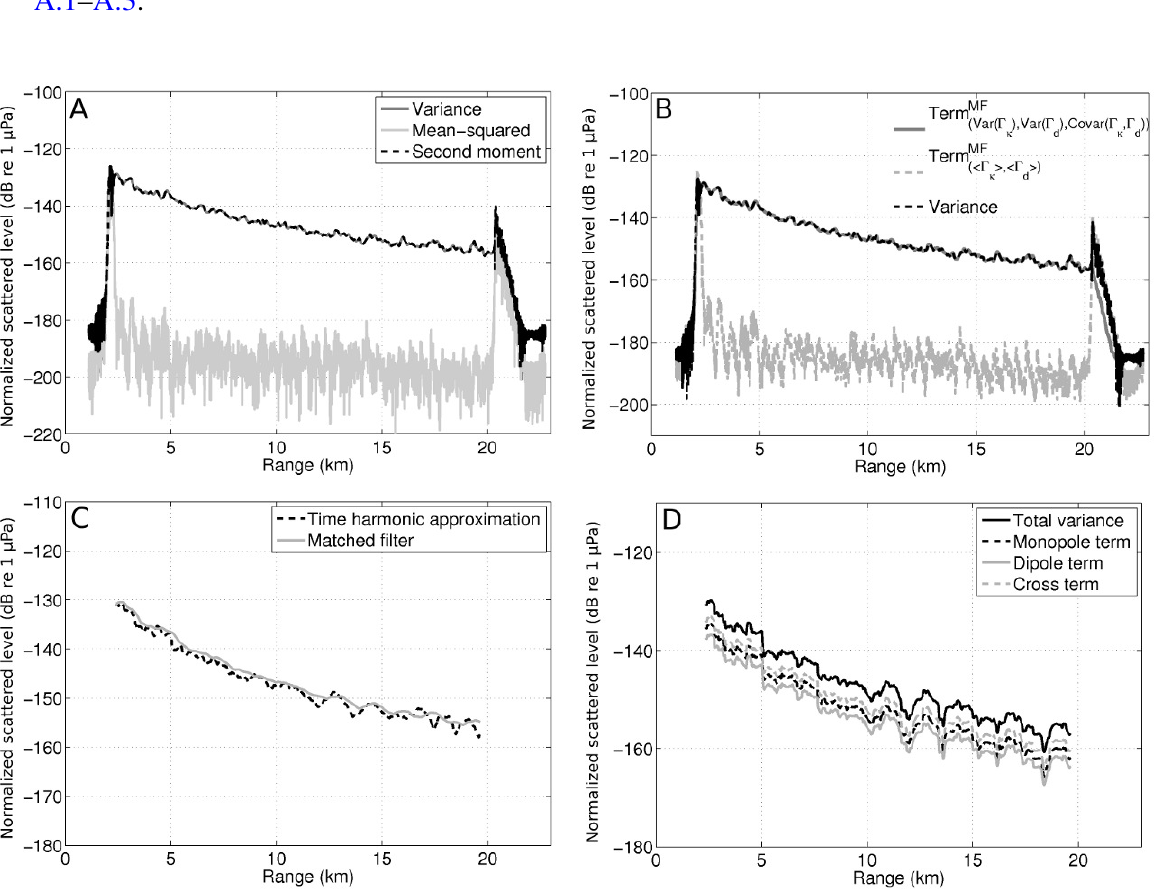
Figure A.5. The modeled ( A ) total moments of the matched-filtered seafloor scattered field; ( B ) matched-filtered scattered field variance and its components; ( C ) range-averaged matched-filtered scattered field variance compared to the range-averaged variance at the center frequency or time-harmonic approximation; and ( D ) range-averaged variance term Term TH compared to its three components, monopole, dipole and < Var (Γ κ ) ,< Var (Γ d ) ,< Covar (Γ κ , Γ d ) cross terms at the center frequency. The source is assumed to be a linear frequency modulated (LFM) pulse centered on 415 Hz and with a bandwidth of 50 Hz. Computations are for a seabed patch extending from 2 km to 20 km in the range, 3 ◦ in the azimuth and 10 m in depth, in a Pekeris sand waveguide, as shown in Figure A.4. The cross range resolution of 3 ◦ is the typical angular resolution of the OAWRS receiver array [9,10], and the range resolution, ∆ r = c/ 2 B , is 15 m for sound speed c = 1 , 500 m/s and OAWRS bandwidth B = 50 Hz. The source and receiver are co-located at a depth of 50 m. Detailed derivations of the normalized broadband seafloor scattered field and its moments are given in